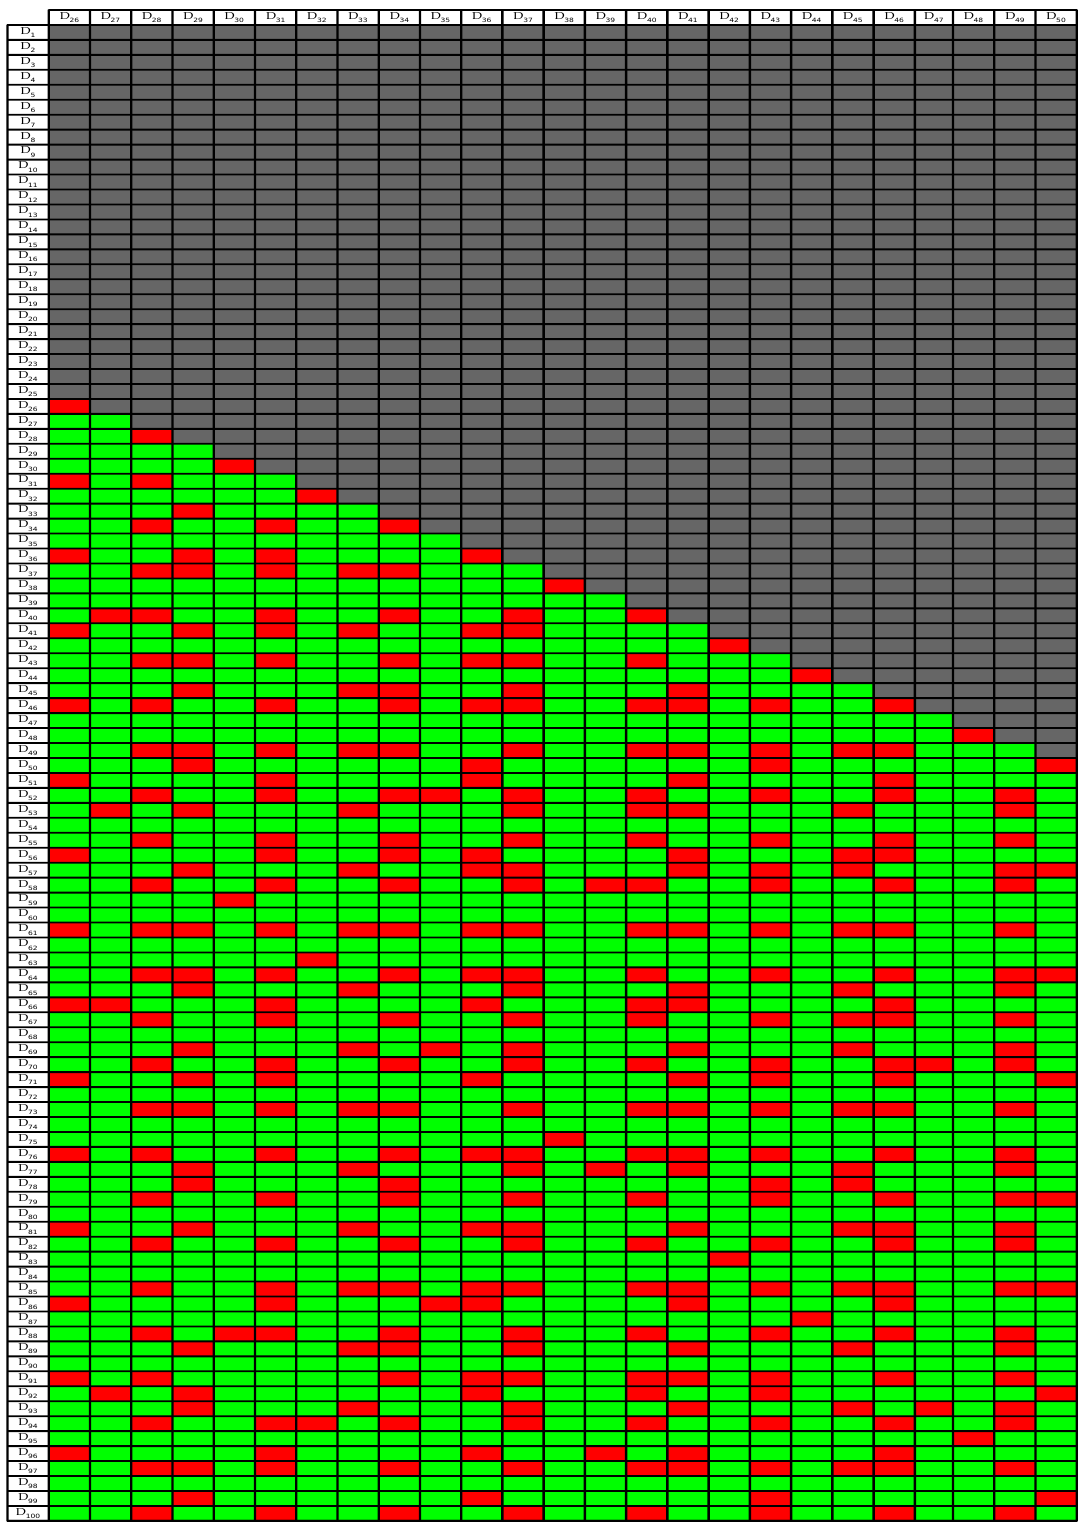
Table 11 . Analyzed theories for ( D n ; D m ) with n = 3 ; : : : 100 and m = 26 ; : : : 50.